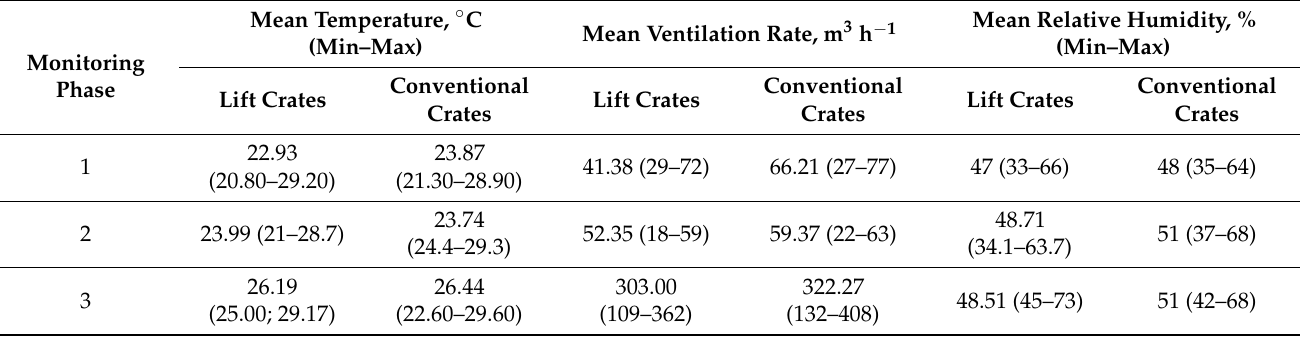
Table 3. Environmental conditions in the farrowing